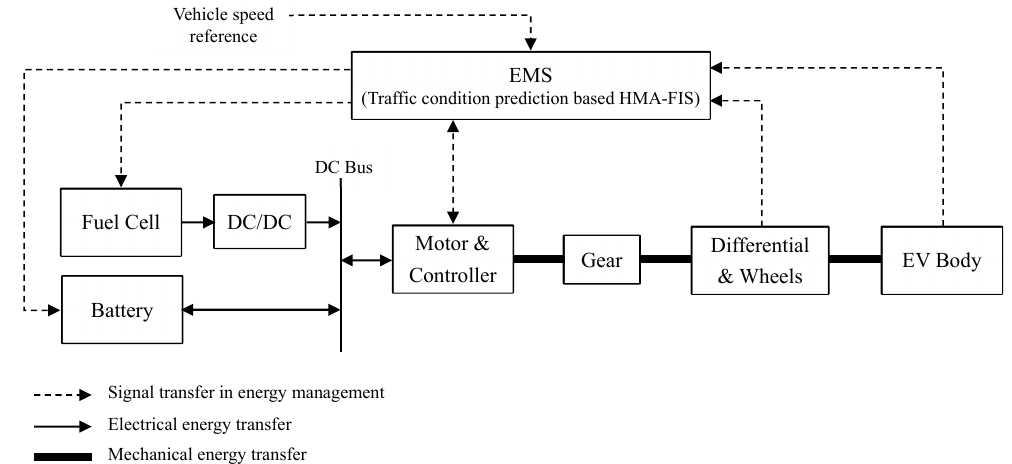
Figure 1. Structure of fuel-cell electric vehicle (FCEV) powered by fuel cell and battery with proposed energy-management strategy